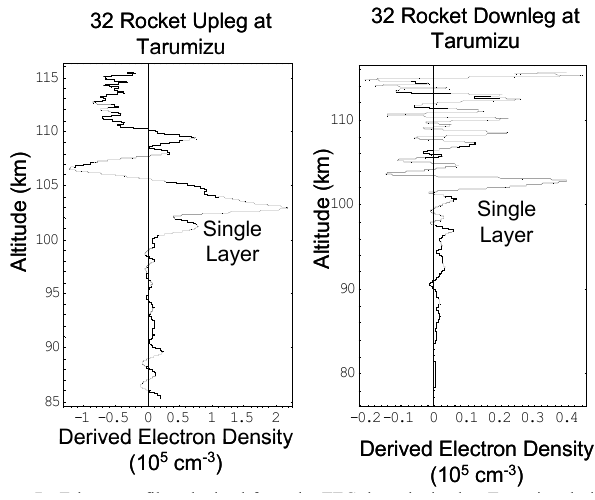
Figure 7. E layer profiles obtained from the TEC data obtained at Tarumizu during the flight of the second SEEK2 rocket. Fig. 7. E layer profiles obtained from the TEC data obtained at Data from in situ plasma sensors on the SEEK2 rocket are used for comparison with the Tarumizu during the flight of the second SEEK-2 rocket. DBB results. Figure 8 illustrates the electron current profile from fixed bias probe (FBP)